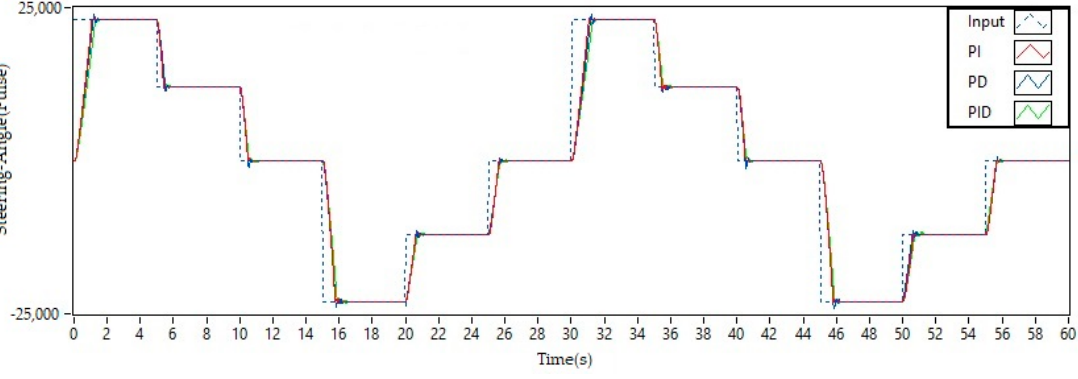
Figure 10. Position control response to the up-down-up input signal .